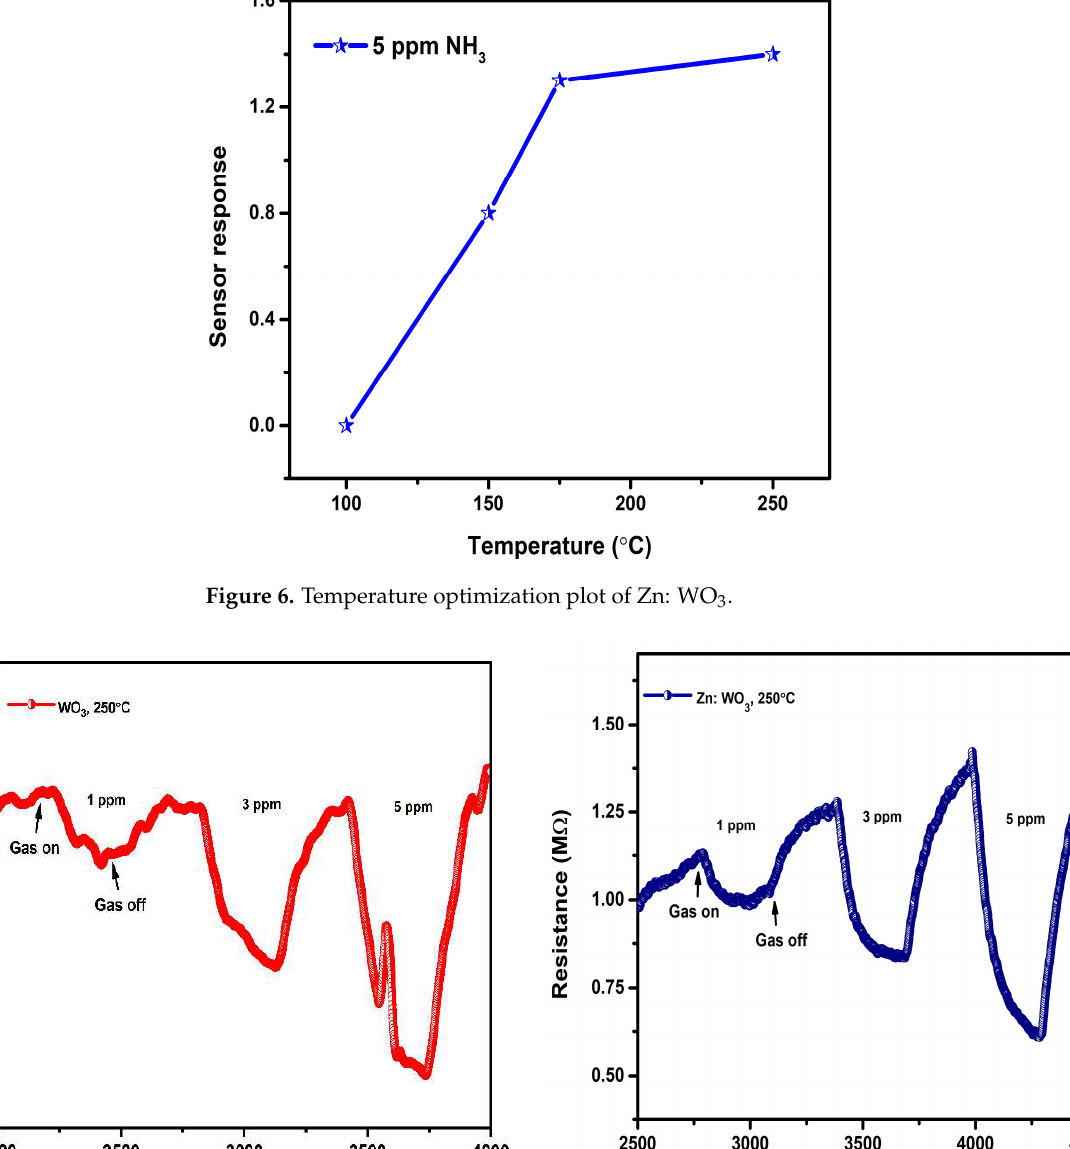
Table 2. Sensing parameters of WO 3 and Zn: WO 3 films.